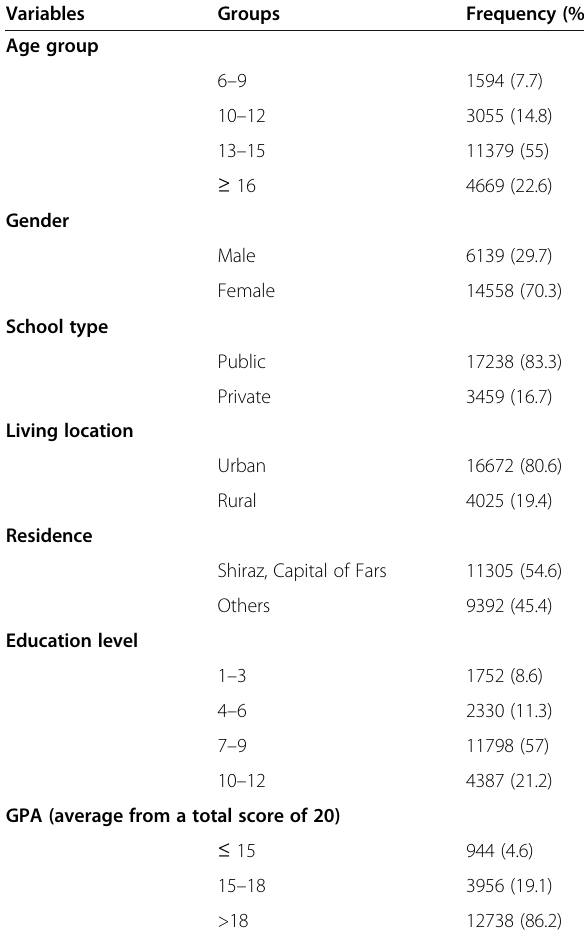
Table 1 Demographic features of students in Fars province